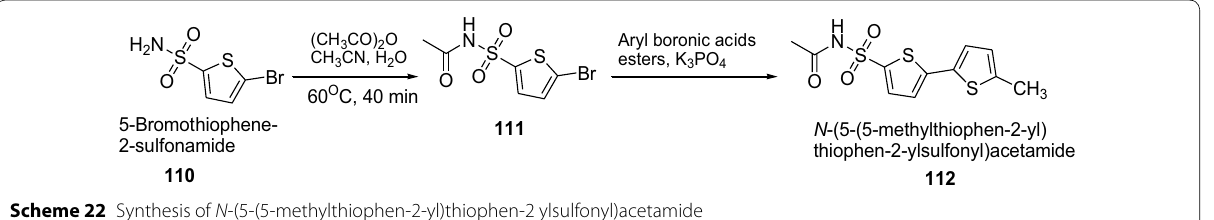
Table 24 Urease inhibition studies of 5-arylthiophene-2-sulfonylacetamides